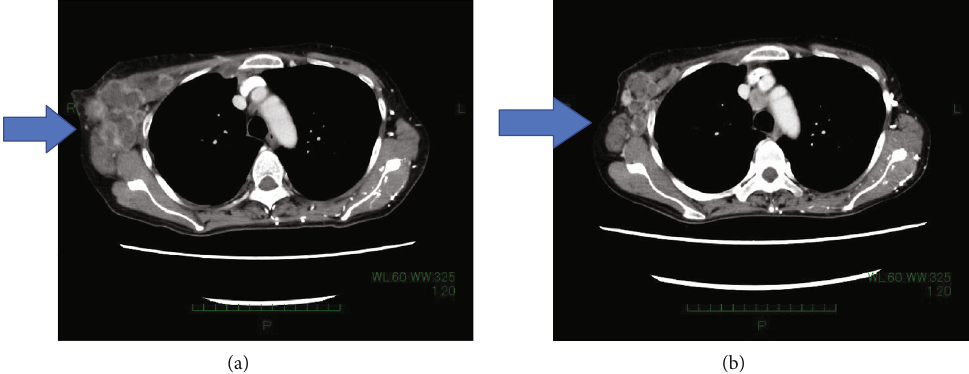
Figure 4: (a) CT scan section showing right axillary lymph nodes before treatment. (b) CT scan section showing right axillary lymph nodes 6 weeks after treatment initiation. Arrow shows right axillary lymph nodes being decreased after